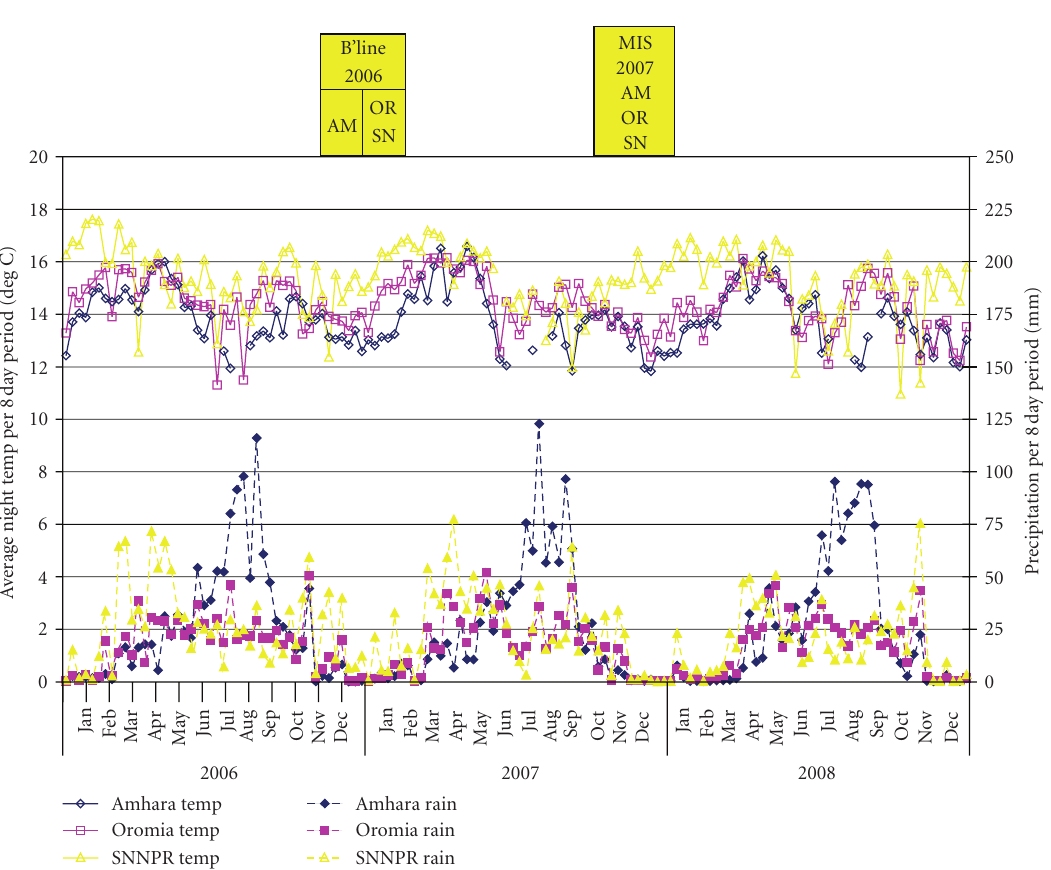
Figure 6: Average nighttime temperature and rainfall over 8 day periods, by survey and regional state. AM: Amhara; OR: Oromia; SN: